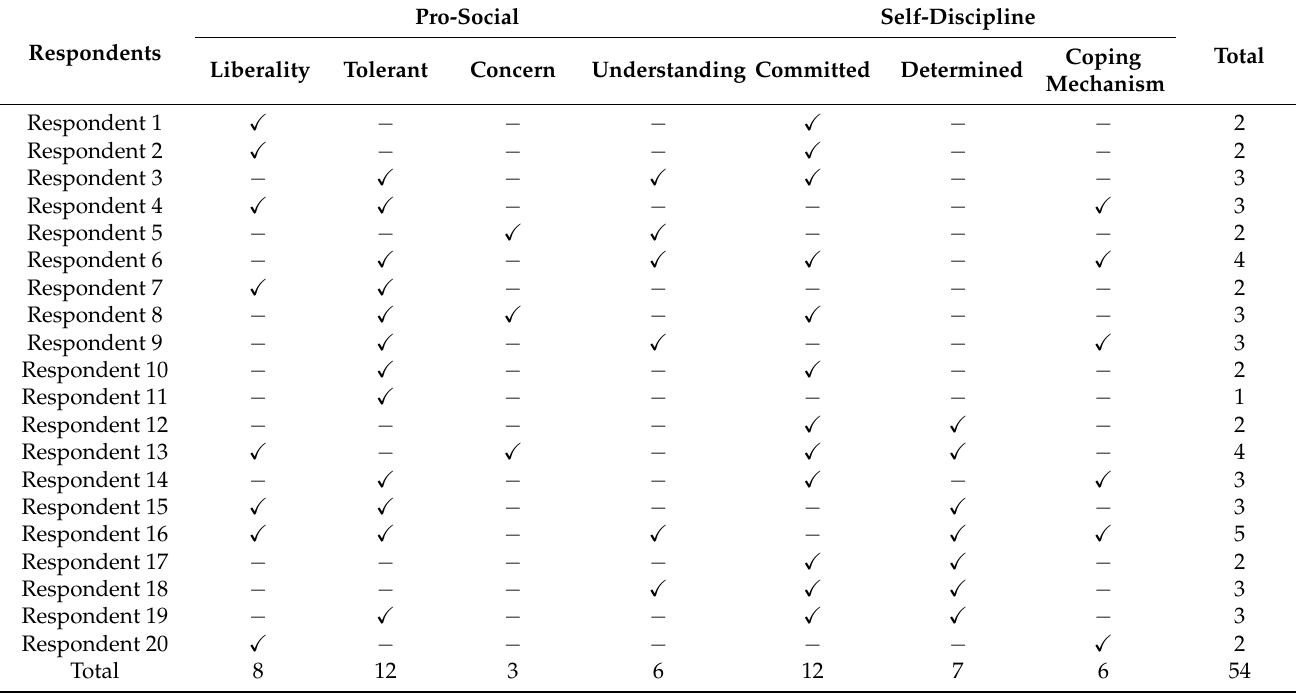
Table 2. Constructive leadership behaviors in BIM-based construction projects.